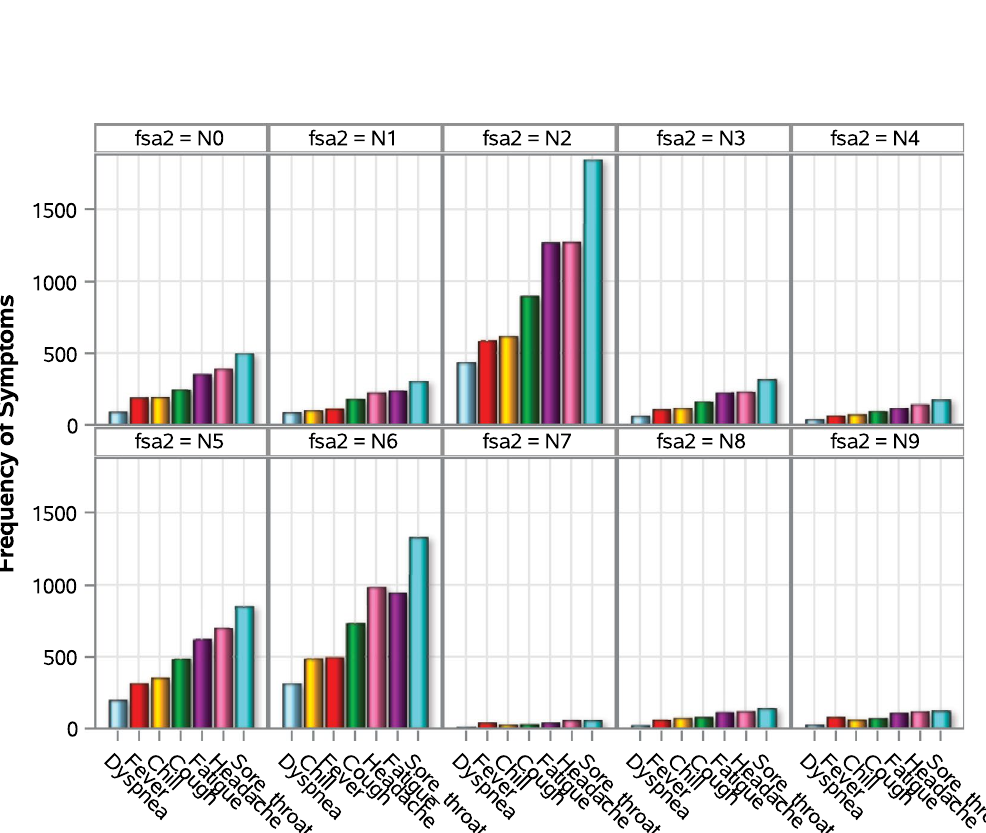
Figure 10. Distribution of the most common symptom types reportd on the portal by postal